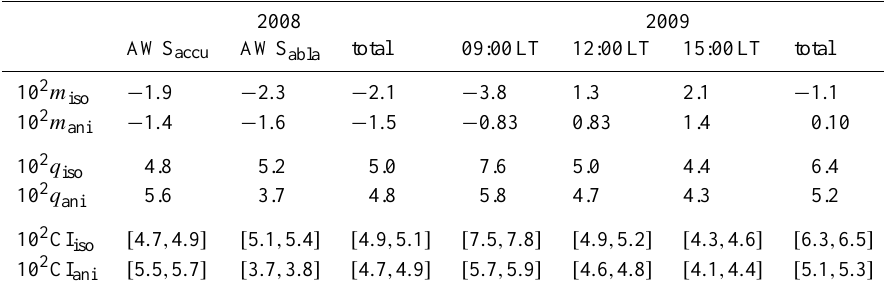
Table 2. Mean ( m ) and root mean square deviation ( q ) of the difference between the albedo retrieved from terrestrial photography and the albedo measured at the AWS. The subscript iso corresponds to the results when ice and snow were assumed to be Lambertian surfaces. The subscript ani corresponds to the results obtained while considering the anisotropy factor. The confidence intervals on q( CI ) were computed at the 99% confidence level as explained in Sirguey (2009, Appendix